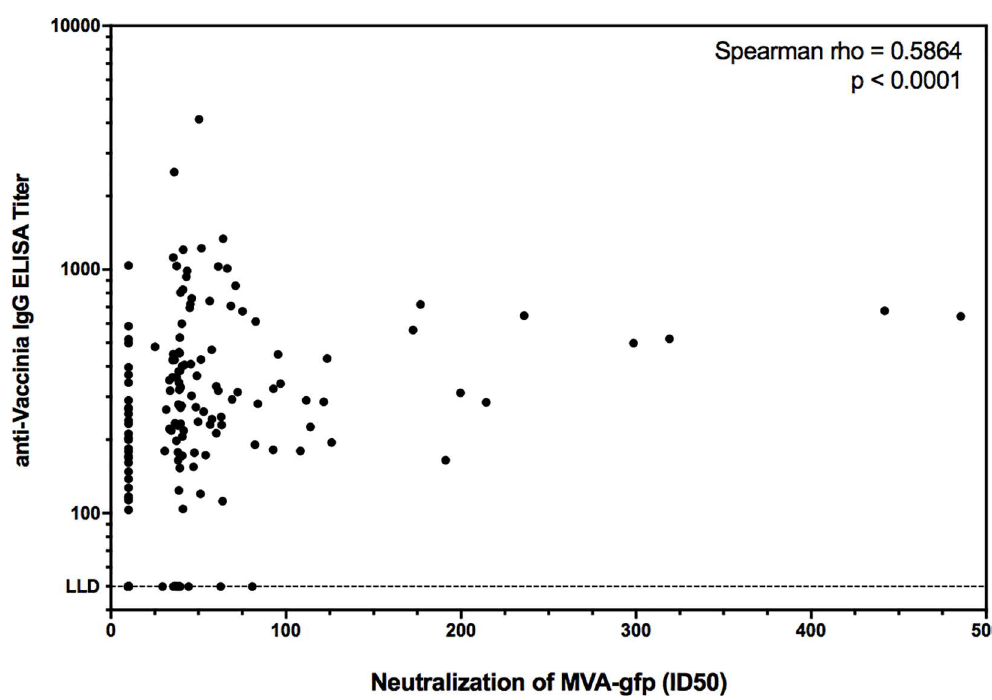
Fig 4. Correlation between anti-vaccinia ELISA and MVA-GFP neutralization. All Dryvax ® samples tested in the MVA-GFP neutralization assay were also assessed in the traditionalanti-vaccinia IgG ELISA. Correlationis shown for the 200 independent cross-sectional samples. Correlationwas analyzedby Spearman ranked sum test. The lower limit of detection(LLD) for the ELISA is